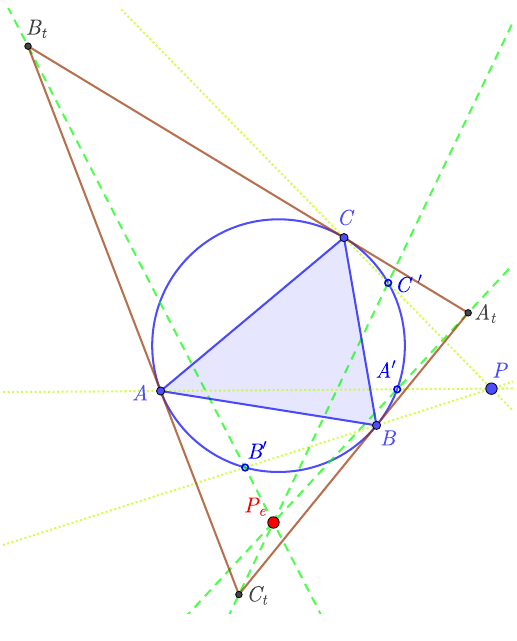
Figure 2. The Exeter